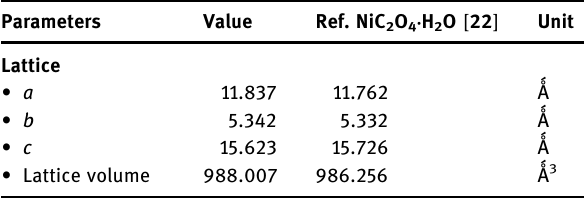
Table 1: Lattice parameter and structural parameter of the as - pre